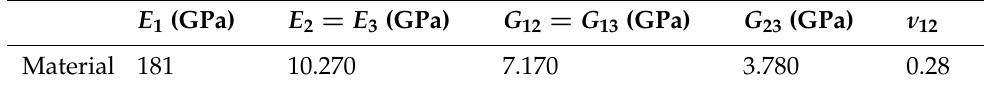
Table 1. Mechanical properties of VAT material